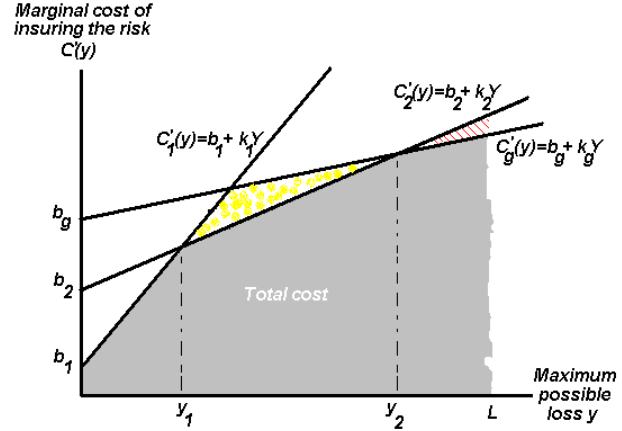
Fig. 4. Government entity as